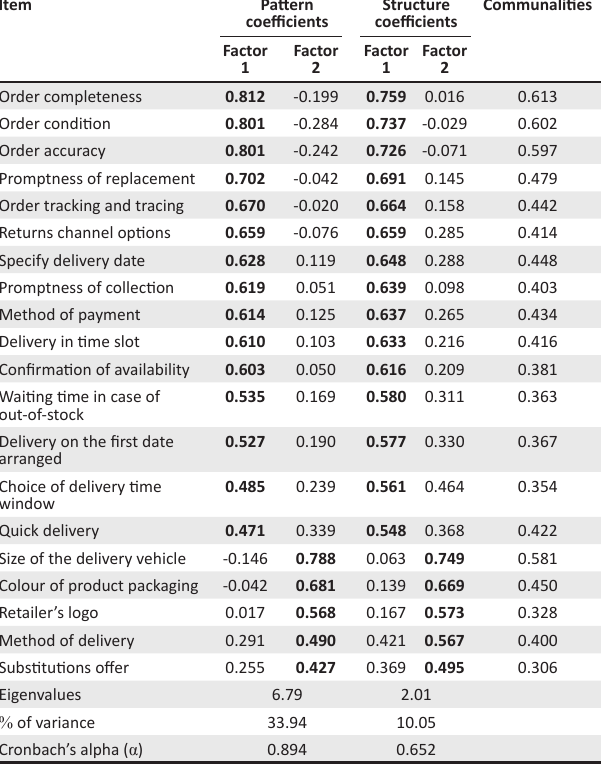
Bold values represent the factor items that are grouped